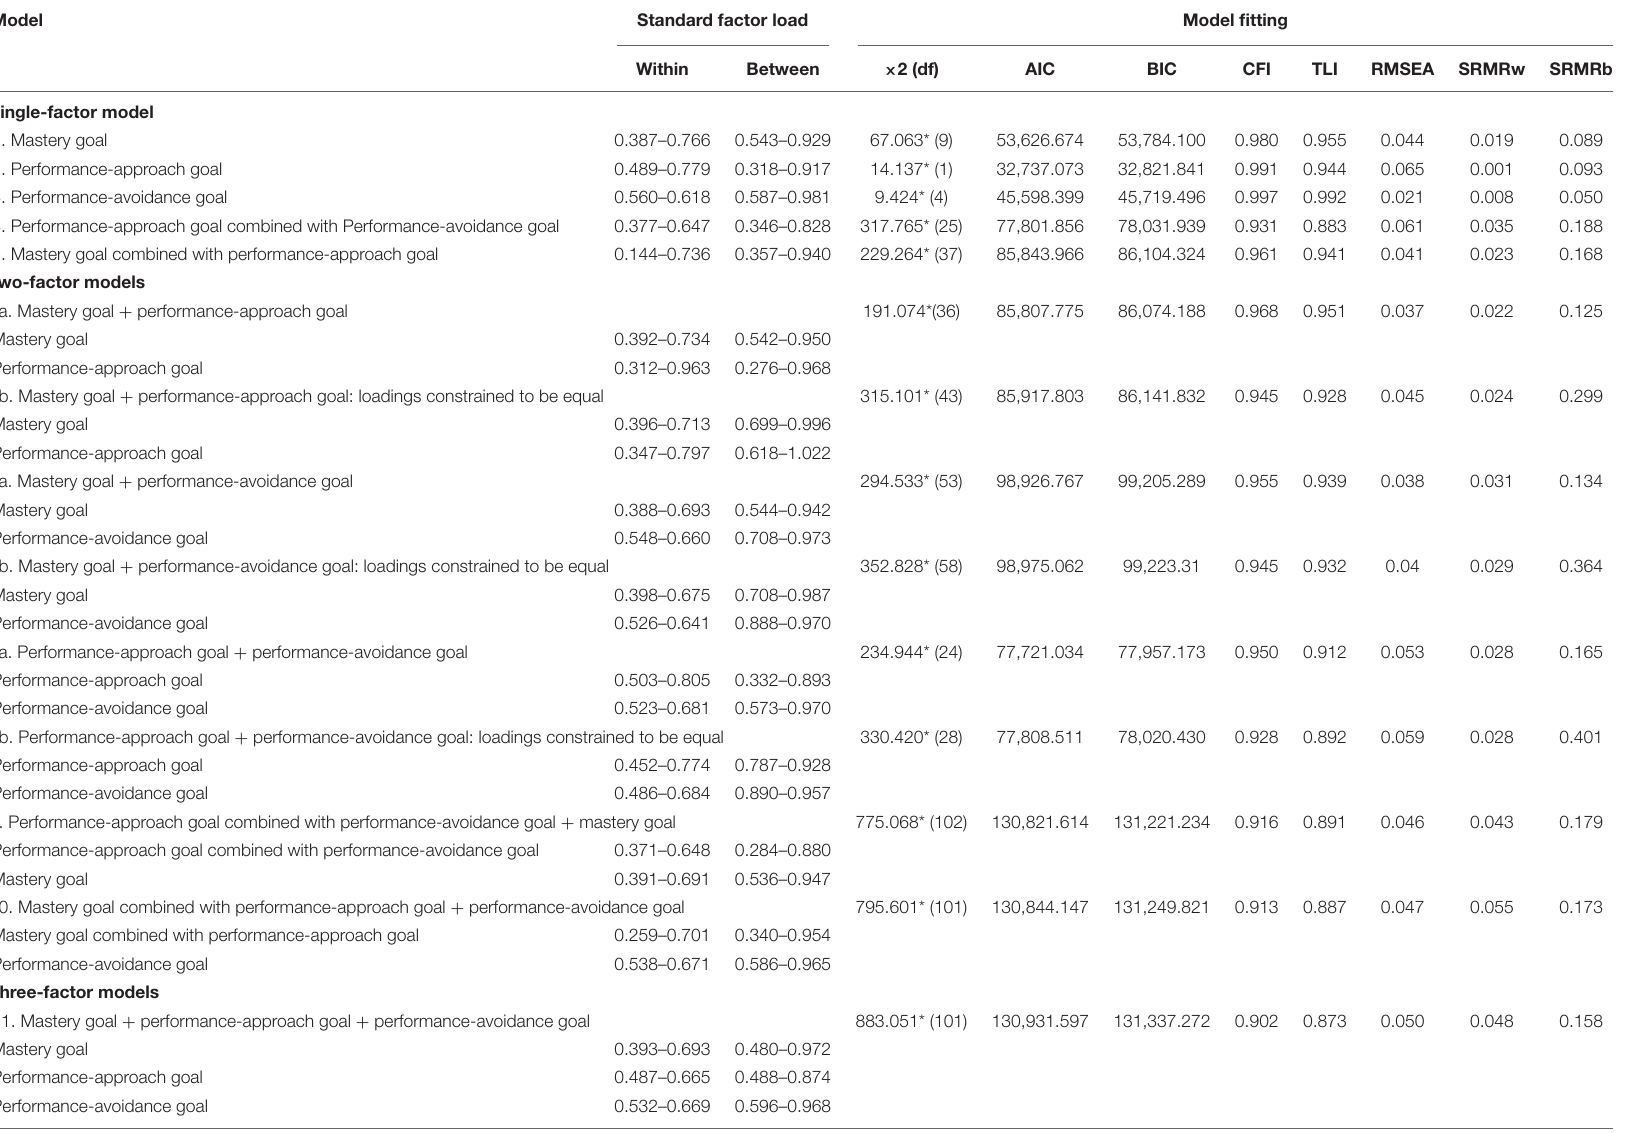
TABLE 5 | Multilevel confirmatory factor analysis